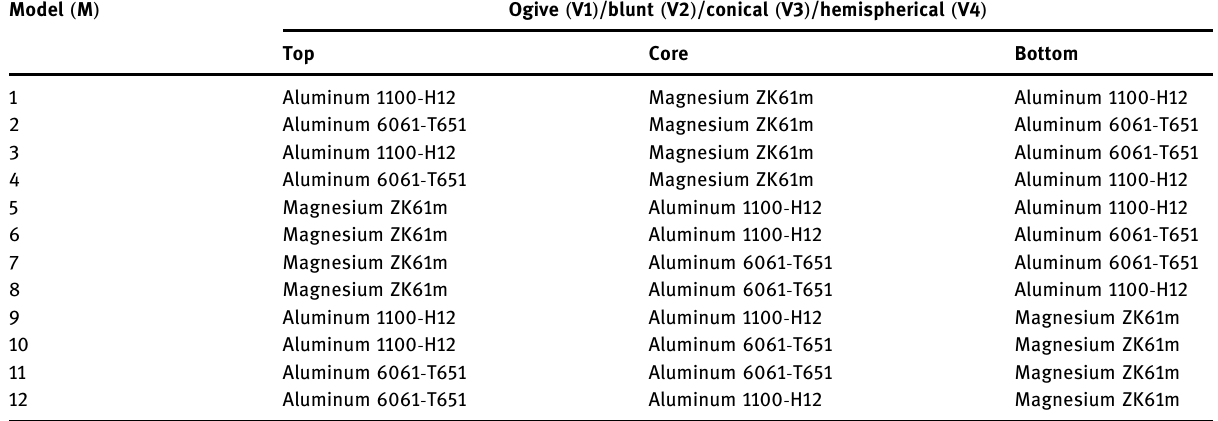
Table 4: Numerical simulation